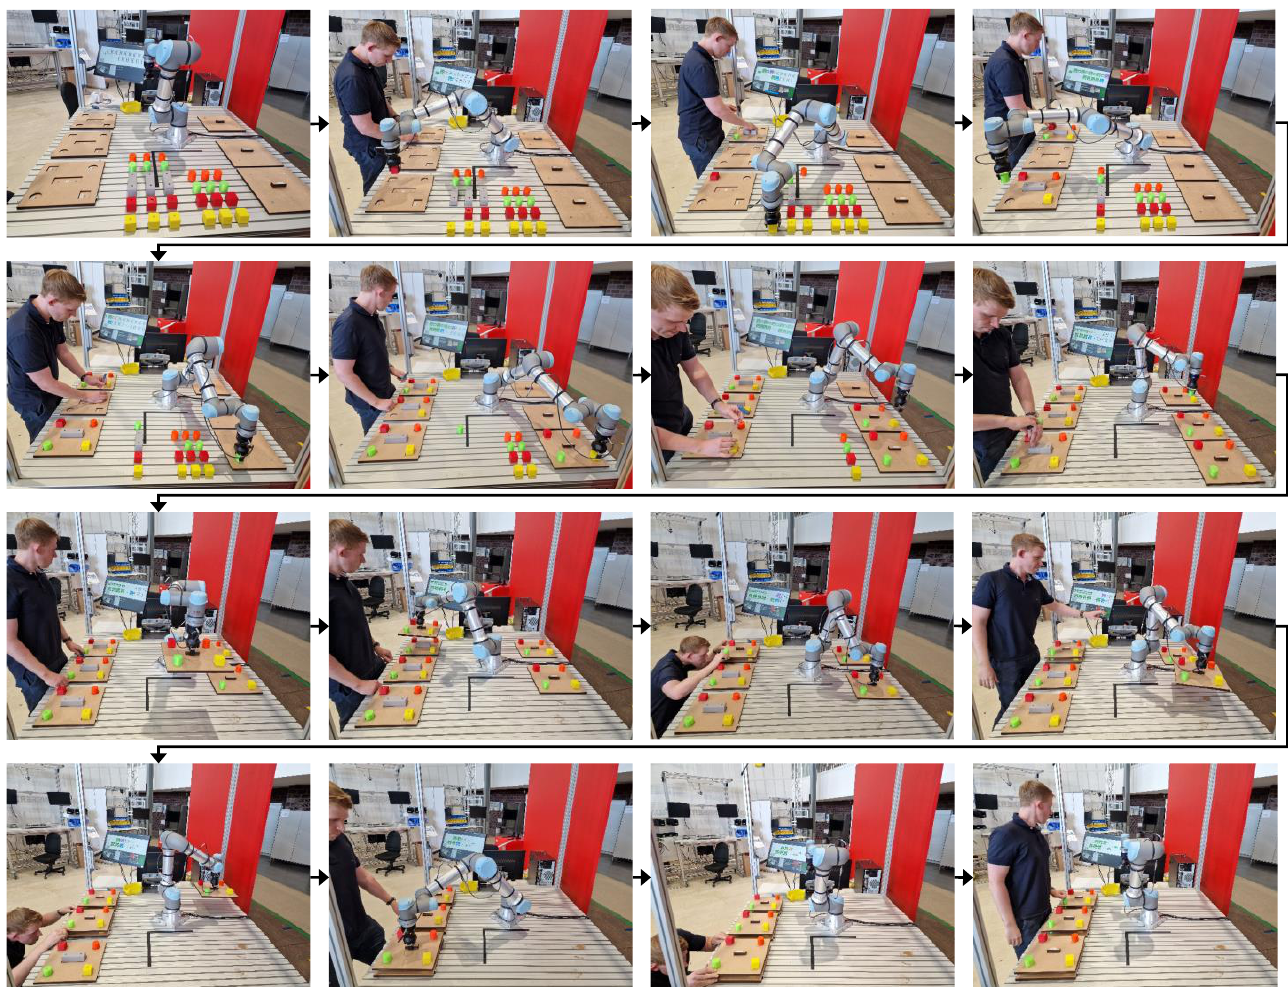
Figure A1. Exemplary process cycle for the assembly of 3 components in human – robot collaboration.